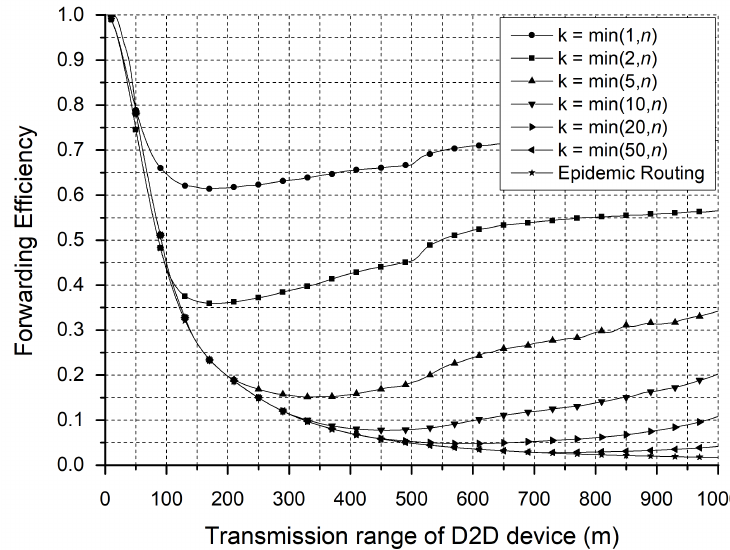
Figure 4. Forwarding efficiency vs. ¯ R when N =